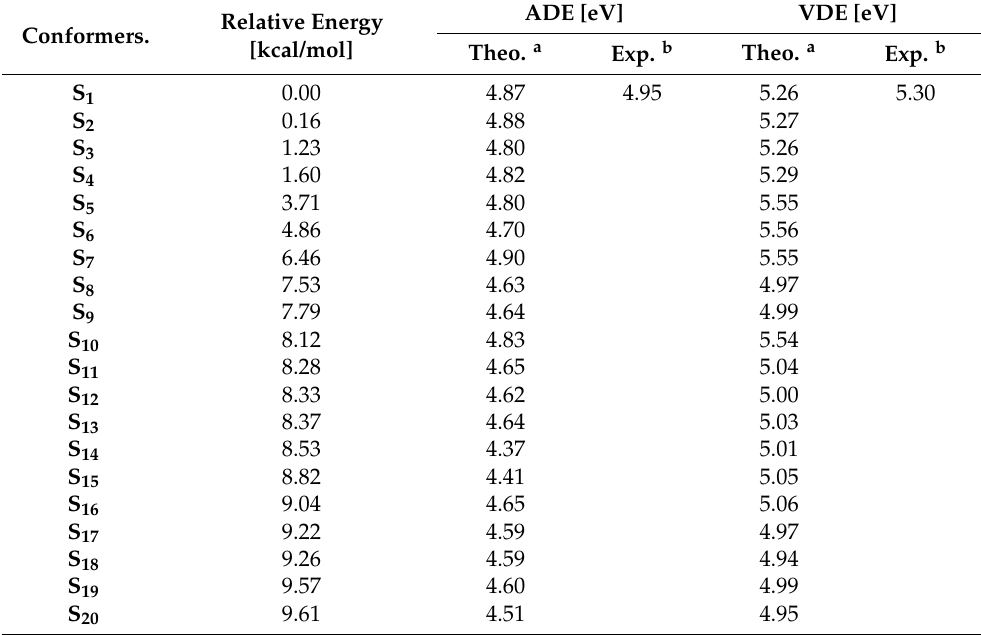
Table 1. Comparison of experimental VDE and ADE values to CAM-B3LYP calculated ones for the top 20 lowest-energy isomers of the cysteine perthiosulfonate anion [cysS-SO 3 ] − . ADE [eV] VDE [eV] Relative Energy Conformers. [kcal/mol] Theo. a Exp. b